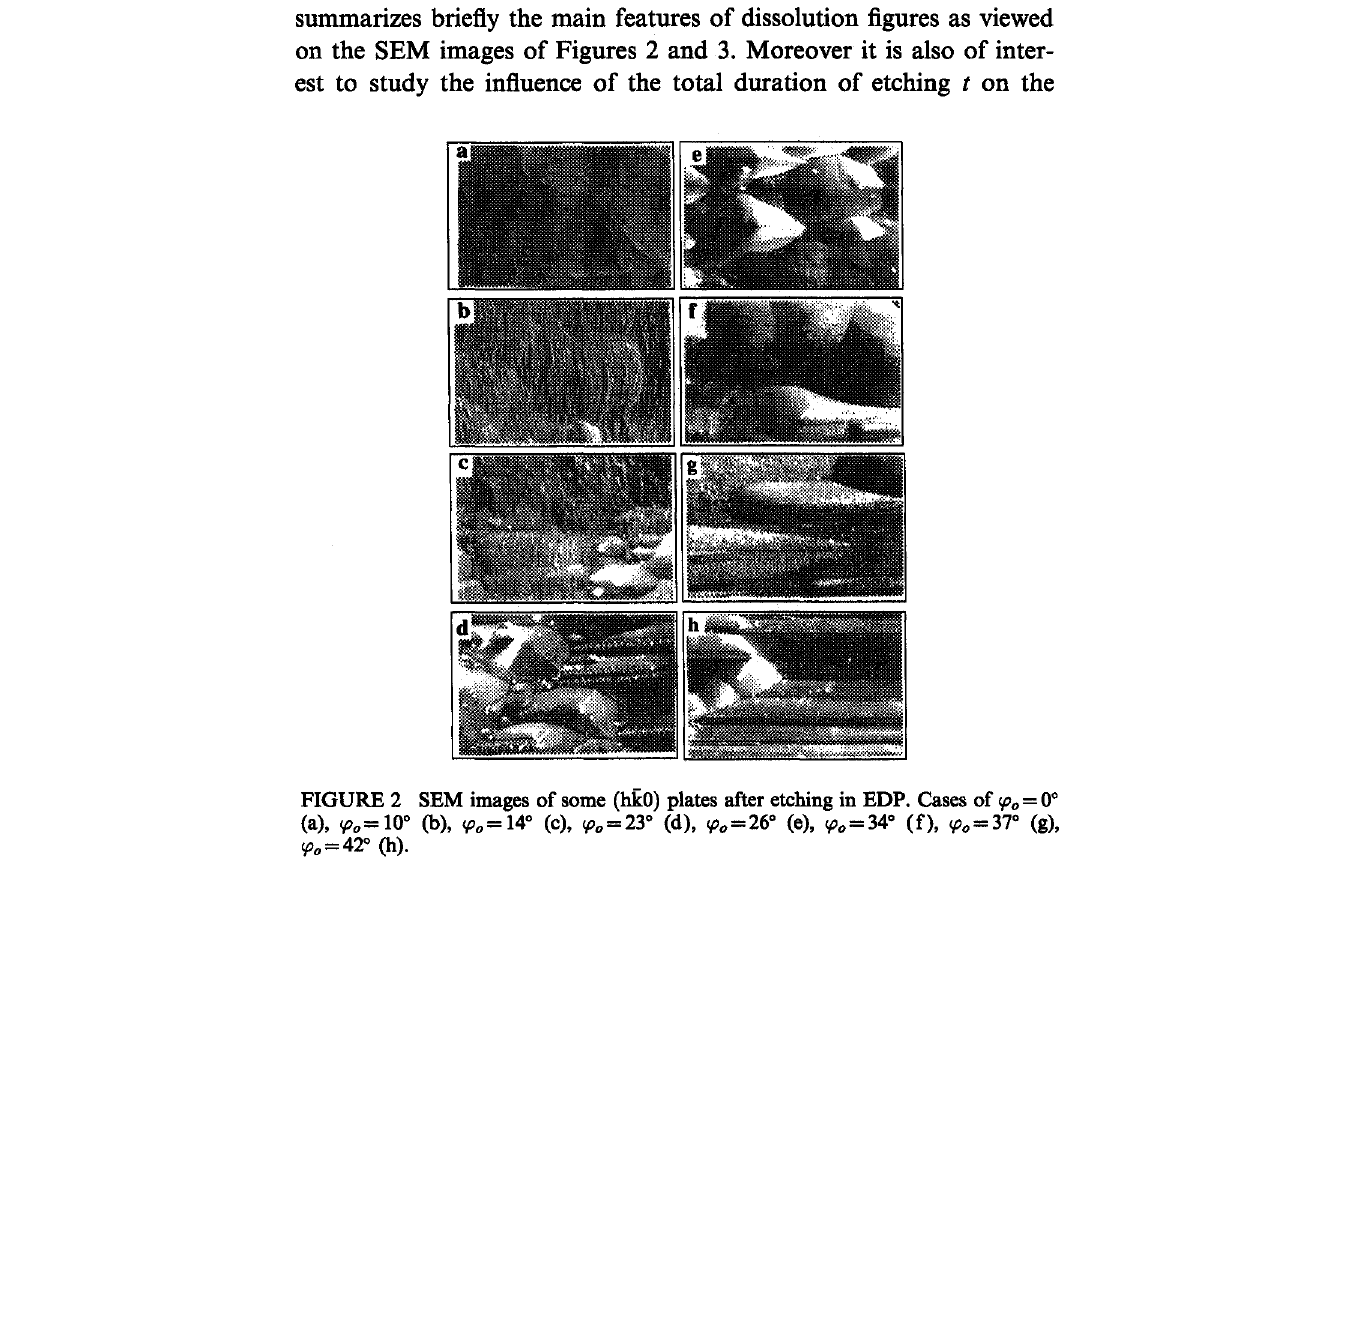
FIGURE 2 SEM images of some (hl0) plates after etching in EDP. Cases of o 0 (a), o 10 (b), po 14 (c), q0o=23 (d), o=26 (e), q0o=34 (f), q0o=37 (g), Oo 42